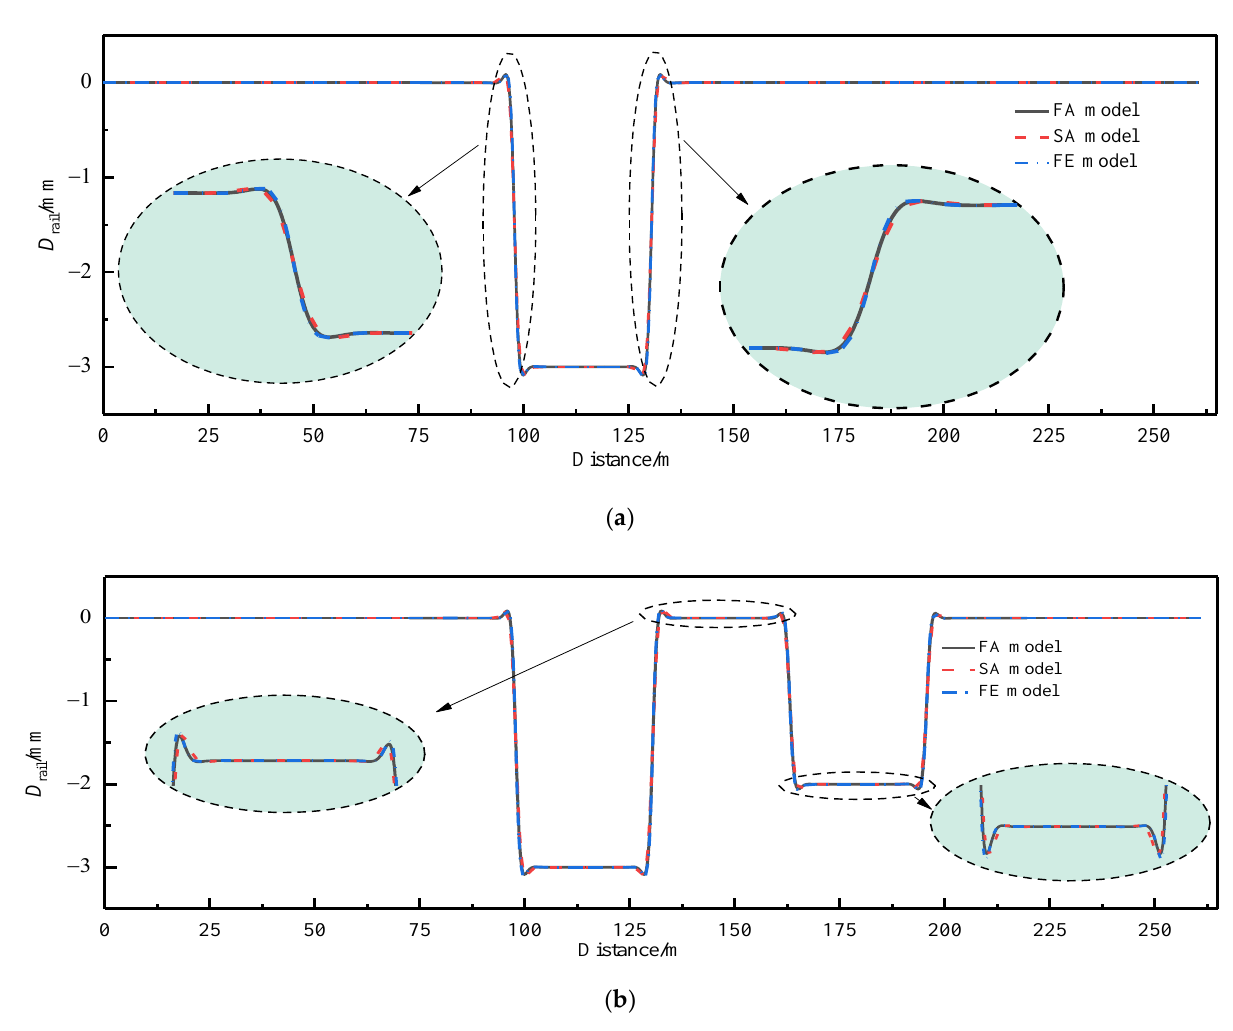
Figure 8. Mapping deformation of the rail under the vertical girder fault. ( a ) third girder vertical fault of 3 mm; ( b ) third girder vertical fault of 3 mm and fifth girder vertical fault of 2 mm.